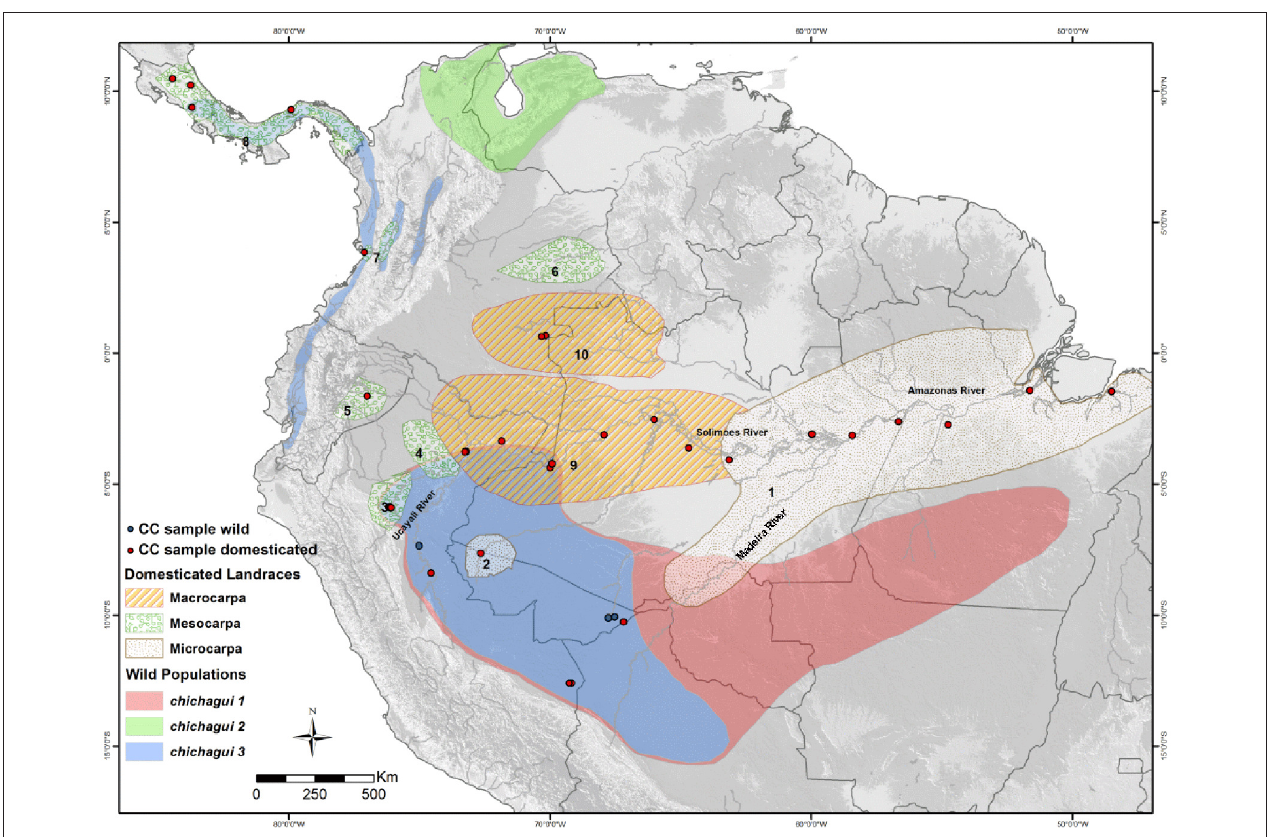
FIGURE 1 | Distribution of wild populations (var. chichagui , types 1, 2, and 3; following Clement et al., 2009b) and domesticated landraces (var. gasipaes ; following Clement et al., 2010) of peach palm ( Bactris gasipaes ) once represented in the Peach palm Active Germplasm Bank at the Instituto Nacional de Pesquisas da Amazônia, Manaus, Amazonas, Brazil. Core Collection (CC) samples within the Peach palm Active Germplasm Bank ( Cristo-Araújo et al., 2015) are identified with blue dots (wild samples) and red dots (domesticated samples). Landrace distributions are in differentially textured areas and numbered: microcarpas (1) Pará and (2) Juruá; mesocarpas (3) Pampa Hermosa, (4) Tigre, (5) Pastaza, (6) Inirida, (7) Cauca and (8) Utilis; macrocarpas (9) Putumayo and (10) Vaupés. See Hernández-Ugalde et al. (2011) for other landraces and